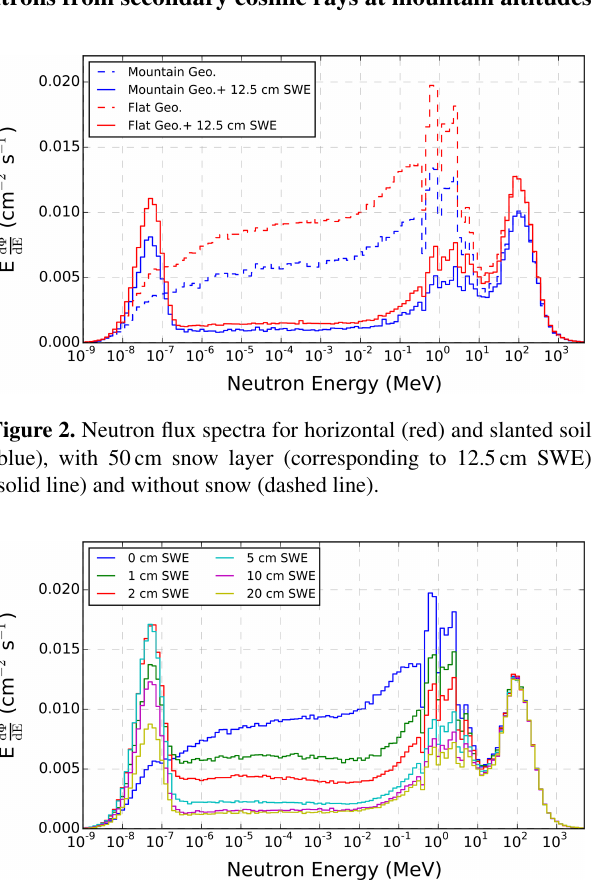
Figure 3. Neutron flux spectra simulated with water layers of dif- ferent heights on